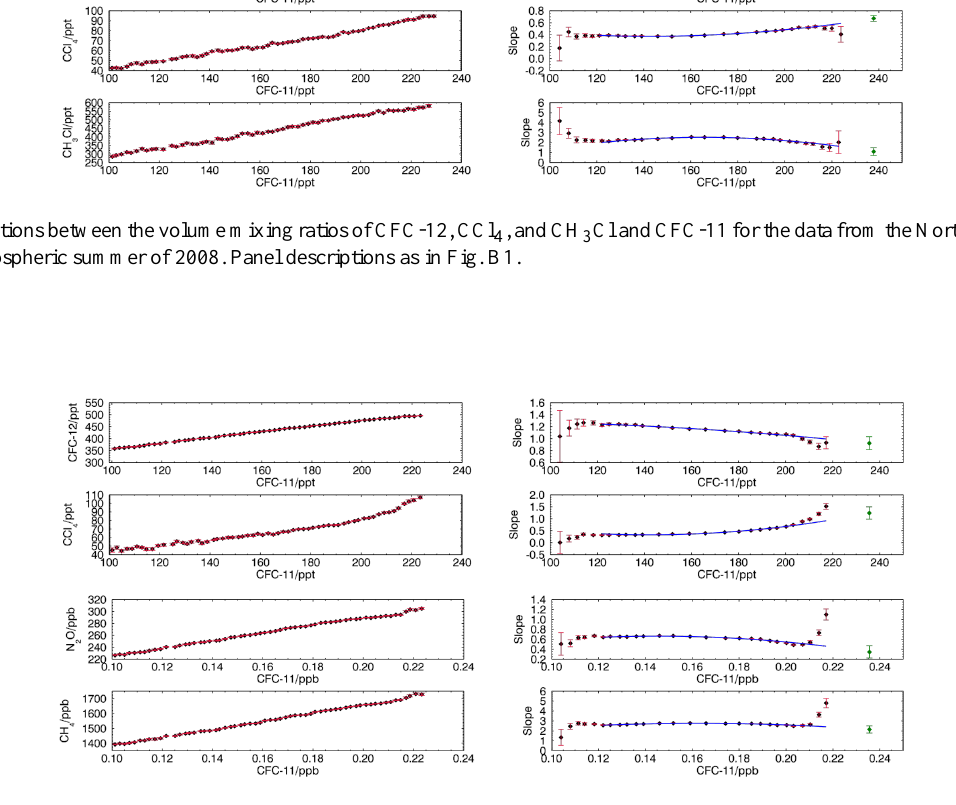
Figure B4 Correlations between the volume mixing ratios of CFC-12, CCl 4 , CH 4 and N 2 O and CFC-11 for the data from the northern hemisphere during the stratospheric summer of 2009. Left panels: The mean correlation profile. Each point represents the mean of the VMR in a window of 2 ppt of CFC-11. The error on these points is the standard deviation of the data within each 2 ppt window. Right panels: The local slope of data in an 80 ppt of CFC-11 window. The error on the points is the fitting error of this fit. The blue line is a second degree polynomial fit to the local slopes. The green point is the extrapolated slope at the tropopause.